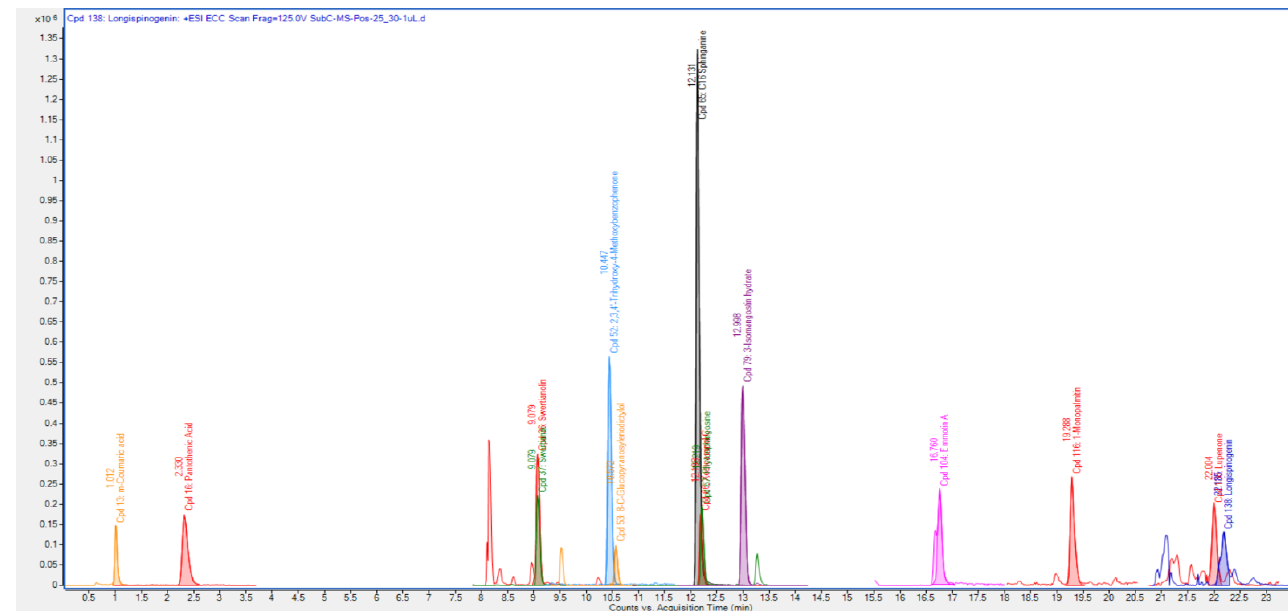
Figure 1. Chromatogram of Q-ToF-LCMS identified compounds.